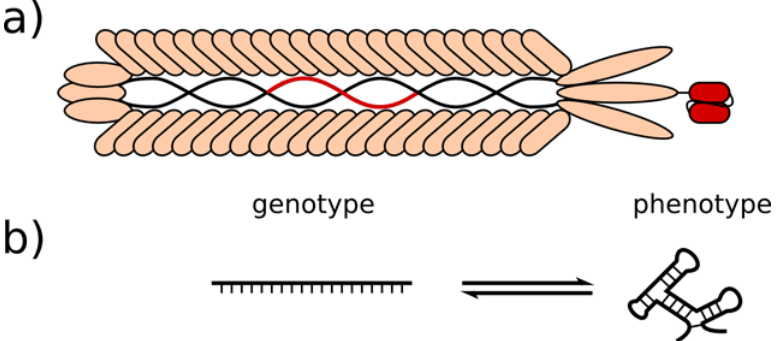
Figure 1. Genotype and phenotype in phage display and SELEX. (a) Schematic drawing of a filamentous phage particle. Encoding segment of single-stranded DNA genome and displayed antibody fragment are coloured in red. (b) Aptamer with interchangeable genotype and